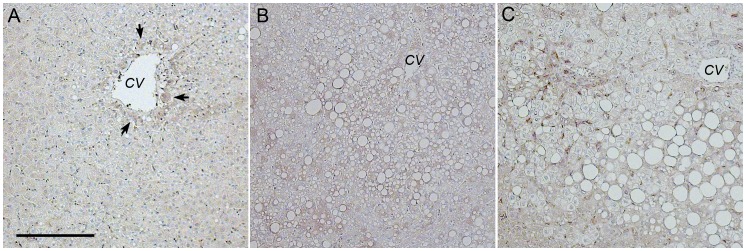
Phosphatidylethanolamine methyltransferase (PEMT) localization differs with progression of NAFLD.Monoclonal antibodies were used to localize PEMT in liver specimens of bariatric subjects sampled intra-operatively at the time of bariatric surgery. (A) The in situ localization of PEMT in an obese normal control subjects was primarily in hepatocytes surrounding the central vein (zone 3; black arrows). (B) PEMT in a SS specimen was localized throughout the liver acinus in zones 1–3. (C) PEMT in NASH specimen accumulated at sites of inflammation (white arrows), as well as in zones 1–3.